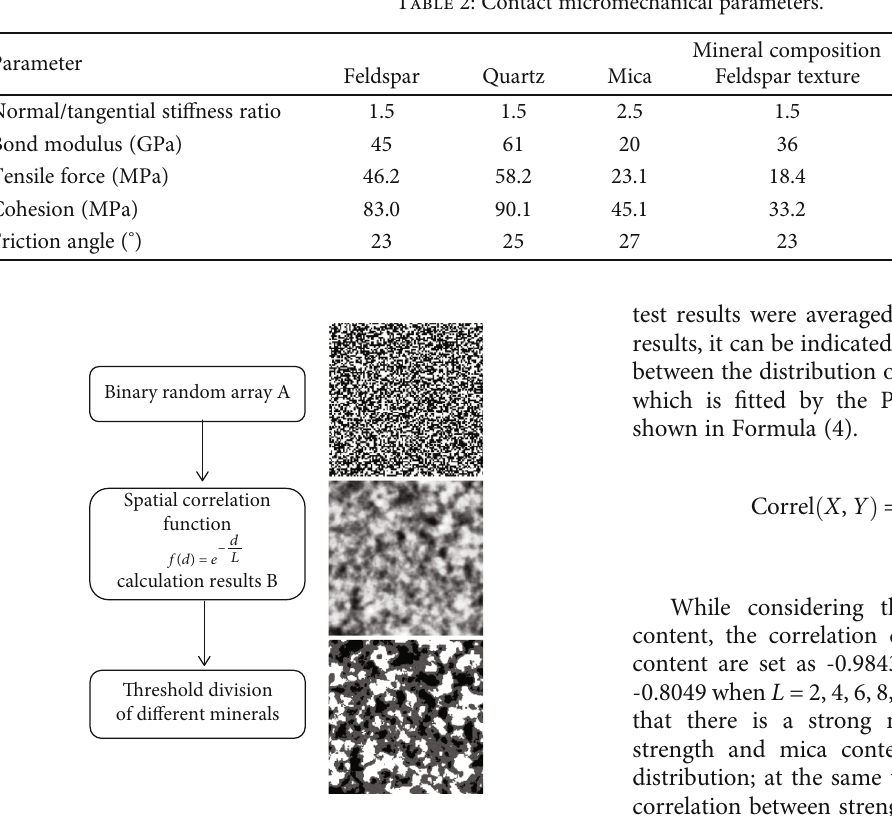
Figure 6: Numerical realization of rock fabric